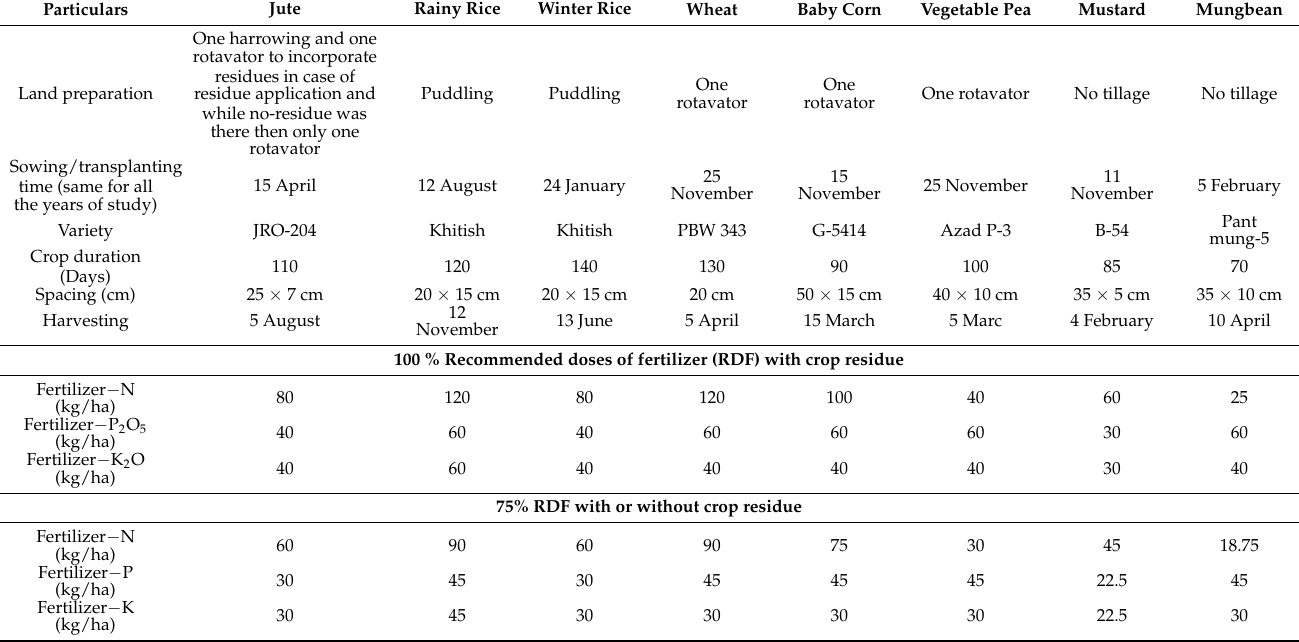
Table A1. Details of cropping systems and recommended dose of fertilizers